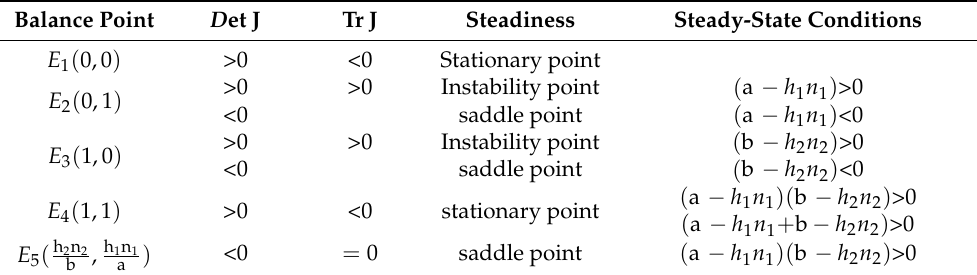
Table 2. Stability discrimination of equilibrium